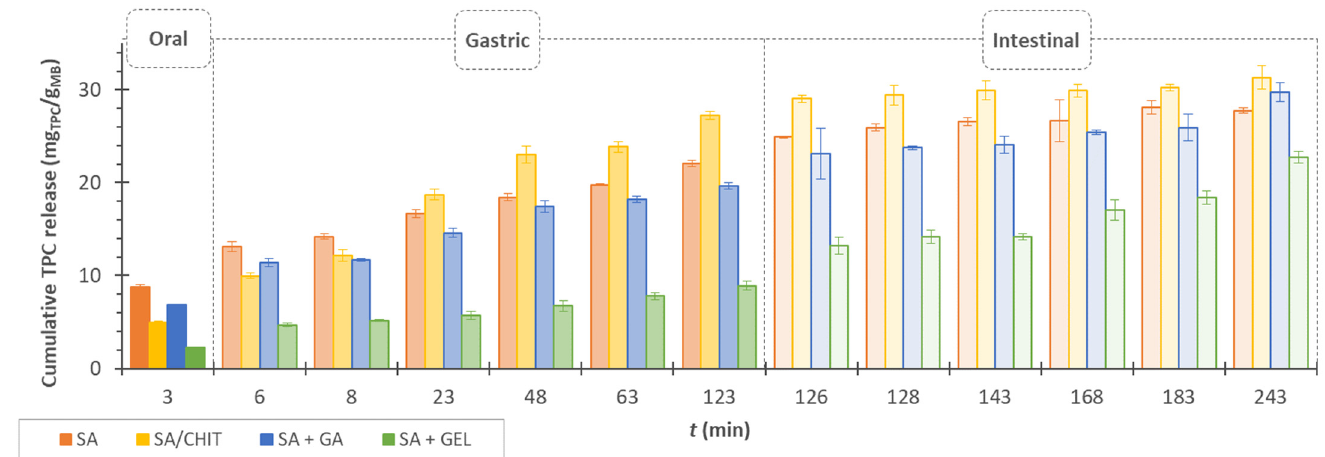
Figure 6. Cumulative release of total phenolic compounds (TPC) from freeze-dried microbeads (MB) containing grape pomace extracts prepared with sodium alginate (SA), sodium alginate with chitosan (SA/CHIT), sodium alginate with gum arabic (SA + GA), and sodium alginate with gelatin (SA + GEL).